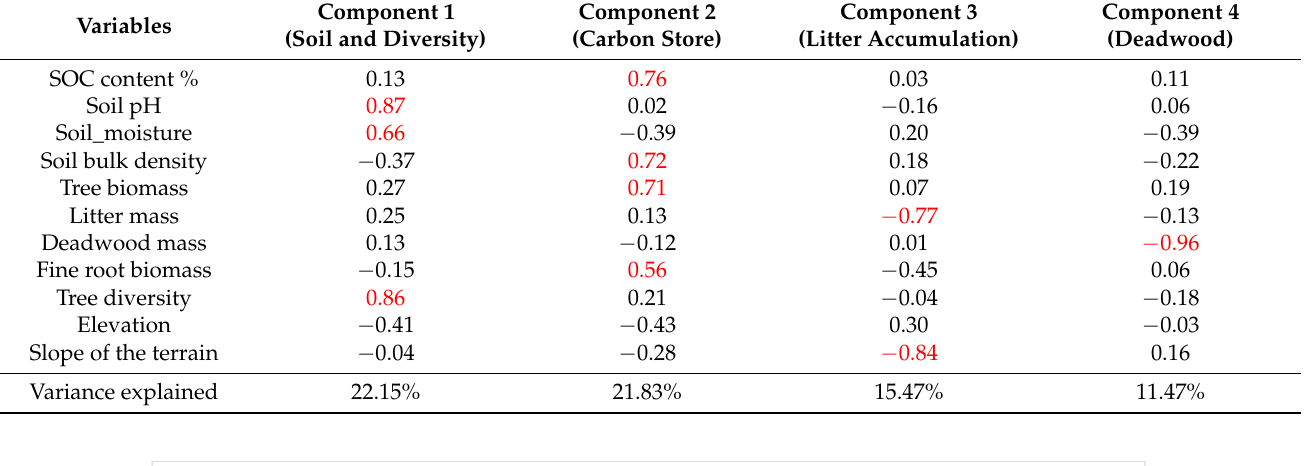
Table 4. Factor loadings extracted from principal component analysis using normalized varimax rotation. Correlations between principal components and predictor variables that are higher than 0.500 are marked in red.